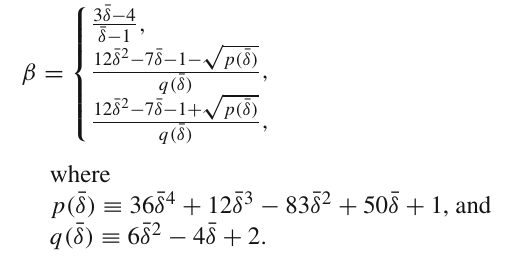
Fig. 1 The plot shows the mutual behaviour of small values of δ and β . It is clear that in the very narrow range, we can consider O ( δ ) ≈ O ( β )